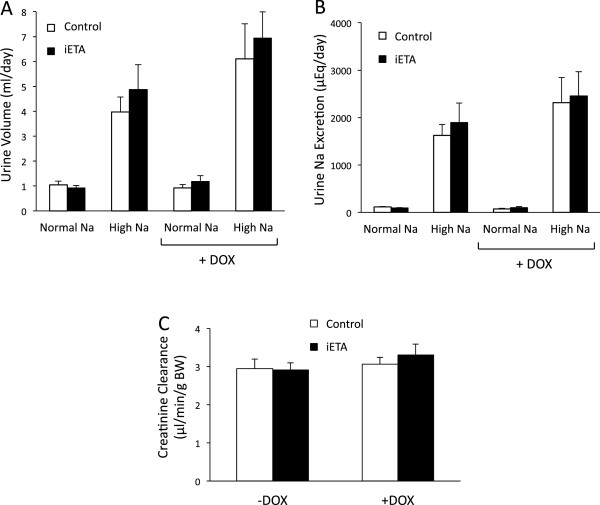
Urine volume (Panel A), urinary Na excretion (Panel B) and creatinine clearance (Panel C) in control and Pax8-rtTA/LC1/floxed ETA (iETA) mice before and after doxycycline (DOX) treatment. Animals were fed a normal (0.3%) Na diet for 3 days followed by a high (3.2%) Na diet for 7 days. Urine (24 hr) was obtained on the third day of starting normal or high Na diets. Note that within each panel, open or closed bars represent the same mice, i.e., mice were sequentially given a normal and high Na diet, treated with DOX, and the diets repeated. N = 8 each data point.